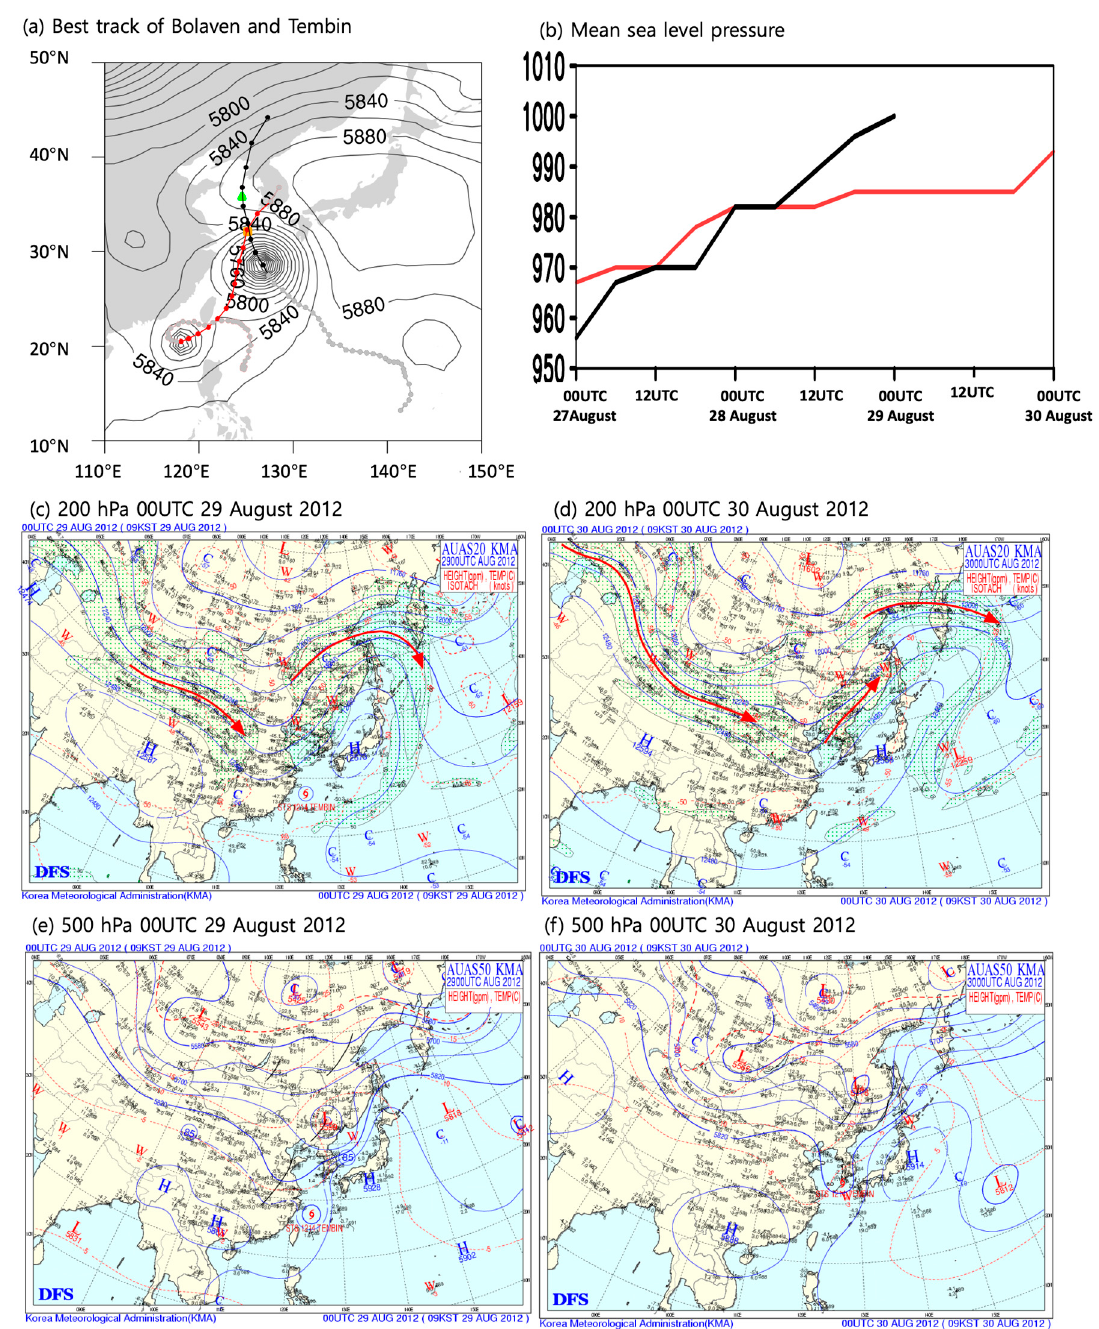
Figure 1. ( a ) Best track of Typhoon Tembin (red solid line) and Typhoon Bolaven (black solid line), green triangle (orange triangle) represent YS buoy (IORS), and ( b ) the mean sea level pressure (unit:hPa) changes in Typhoon Tembin (red solid line) and Typhoon Bolaven (black solid line) obtained from JTWC. A three-day integration is conducted from 00 UTC 27 August 2012 to 00 UTC 30 August 2012. The weather charts during approach Tembin to Korea at ( c – d ) 200 hPa and ( e – f ) 500 hPa from 00UTC 29th Aug 2012 to 00UTC 30th Aug 2012.